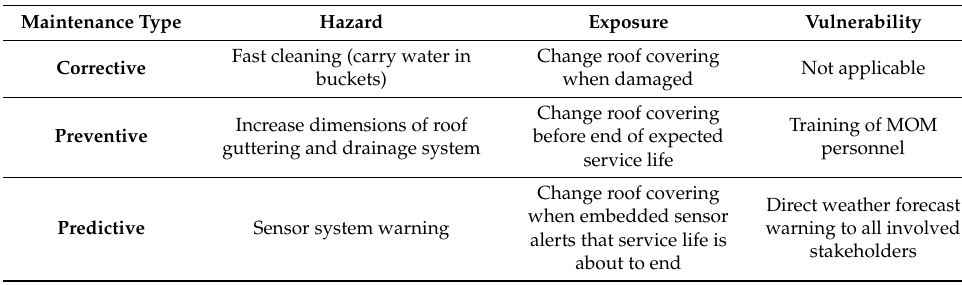
Table 8. Matrix showing the climate-adaptive strategy proposed in this paper. A (potentially) leaking flat roof is taken as an illustrative